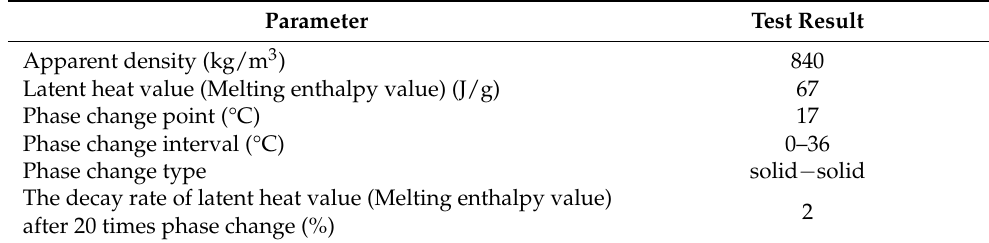
Table 2. The physical and chemical parameters of solid − solid phase change material (PCM). Parameter Test Result Apparent density (kg/m 3 ) 840